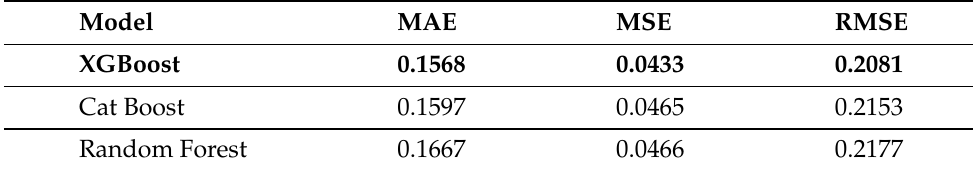
Figure 8. Model feature importance and Shapley feature importance of all three algorithms. Remote- sensing features supersede all weather parameters in importance. Columns 1 and 2 represents the tree and Shapley feature importance scores, respectively. Rows ( a – c ) represents the XGBoost Regressor, Cat Boost Regressor and Random Forest Regressor models, respectively. In all the feature- importance plots, the Growth Stage (GS) and the days after sowing (Daysaftersowing) act as the most important features for predicting disease severity. However, the interpolated remote-sensing-based features (ndvi_rolling_average, ndwi1_rolling_average) supersede the importance of other weather- related features such as wind speed (windSpeedMSAvg), maximum air temperature (airtempCMax) and so on. Table 4. Regression model metrics—without using remote-sensing